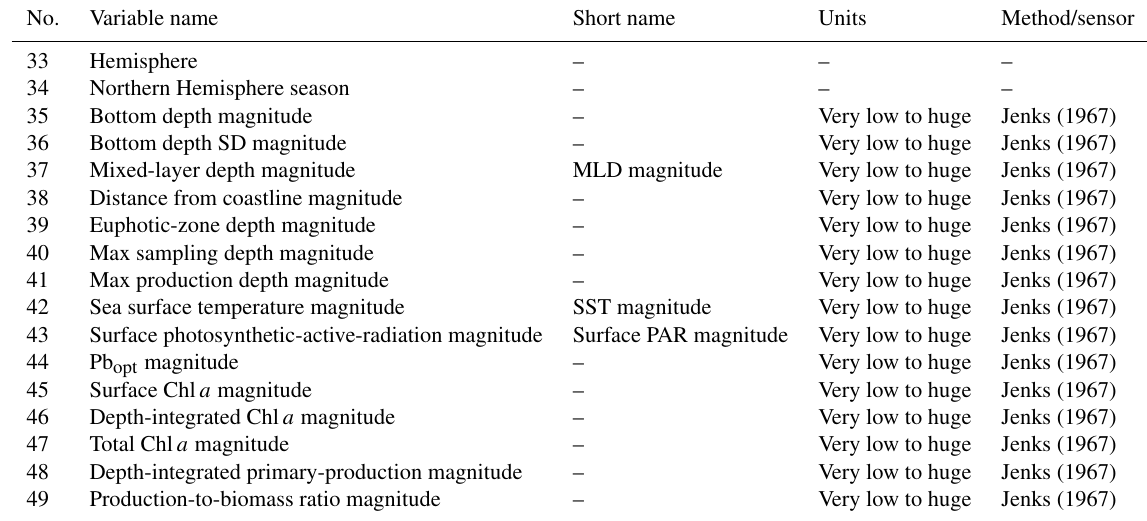
Table 2. Production dataset categorical